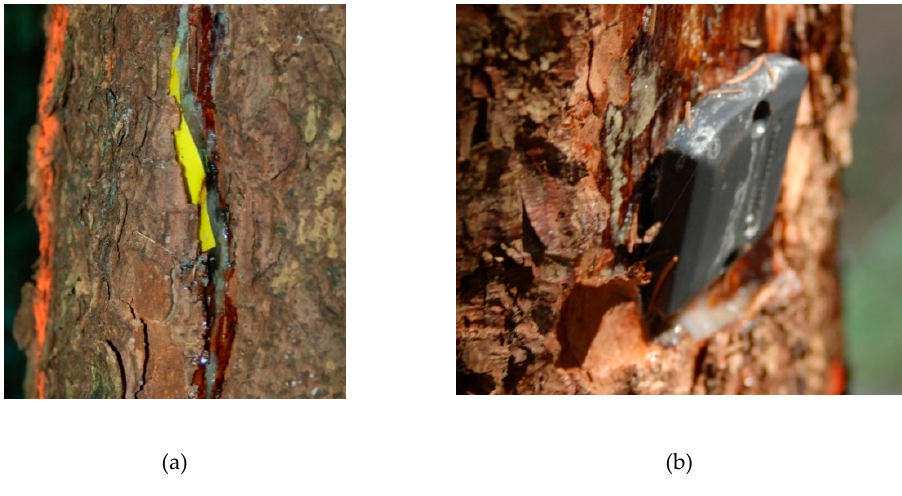
Figure 4. ( a ) SS model and ( b ) CI model after 2 years.